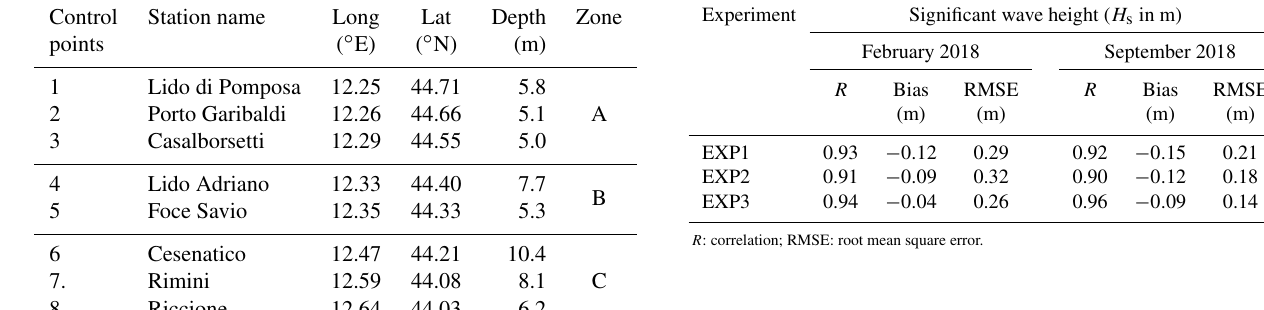
Table 2. Details of control points 1 to 8. Control